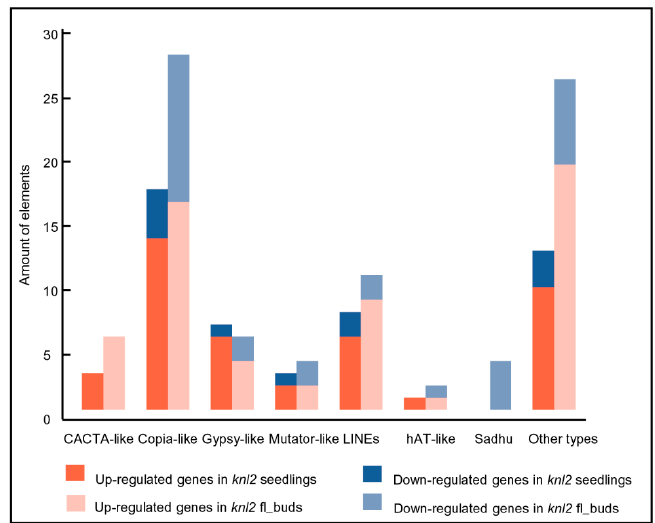
Figure 2. Transposable elements and their amount identified in the knl2 mutant line. Information